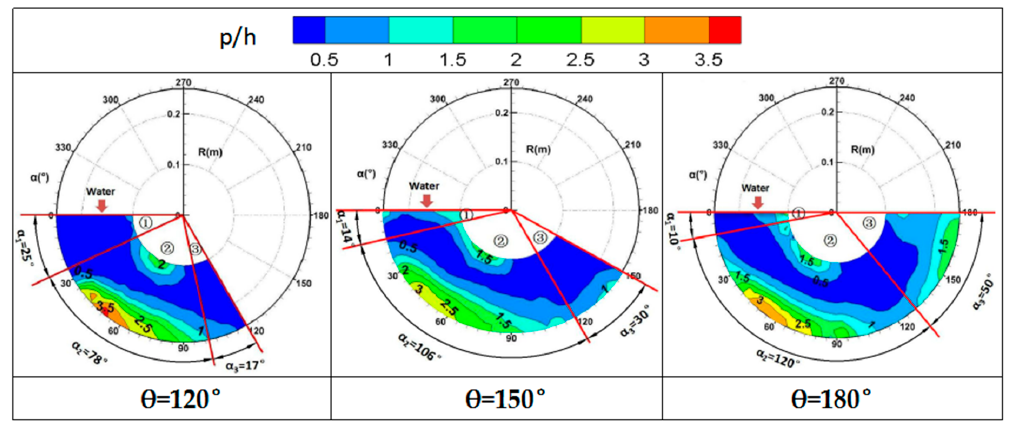
Figure 7. Pressure distribution and flow regions at S6.